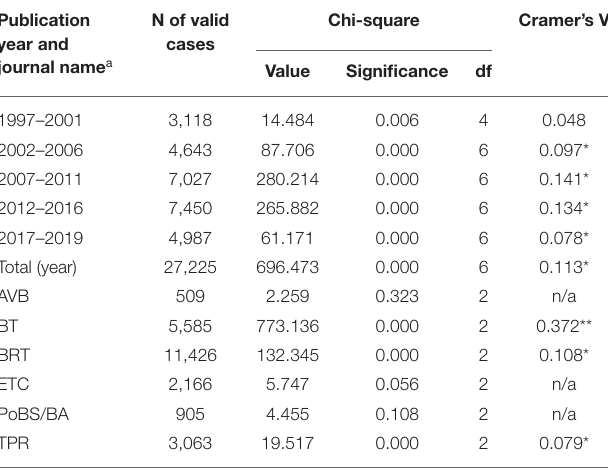
TABLE 5 | Chi-square and Cramer’s V statistics comparing author gender and editor gender by year group and